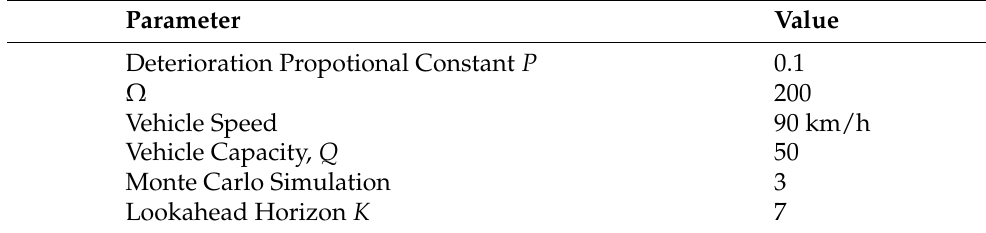
Table 3. Parameter